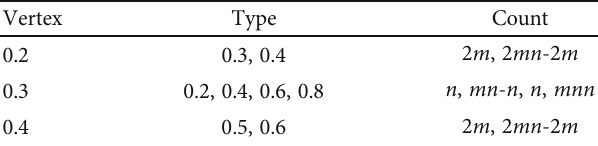
Table 3: Vertex count for general fuzzy